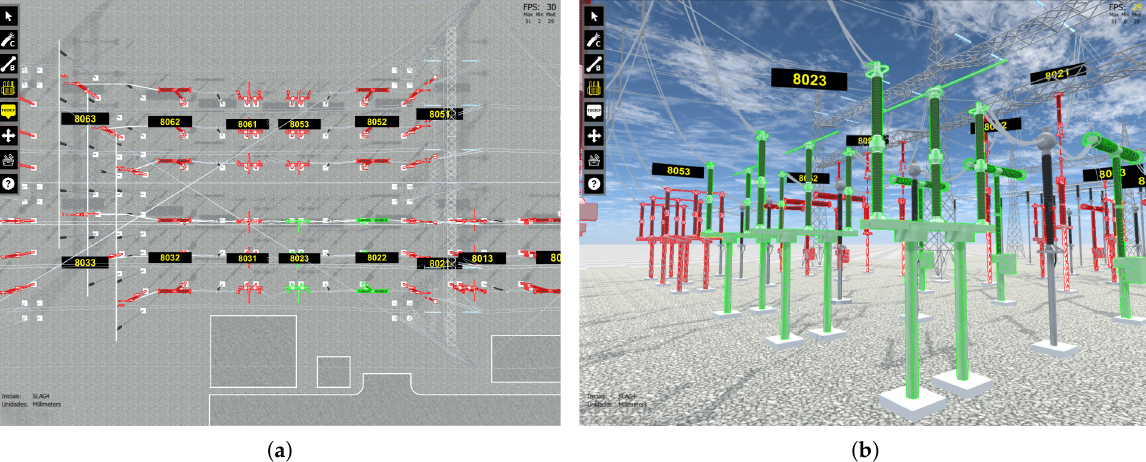
Figure 21. Supervision of the EPS through the VRS: ( a ) top view with emphasis on the labels with asset identification, ( b ) disconnect switch in open state (green/non-energized) with background equipment in closed state (red/energized).